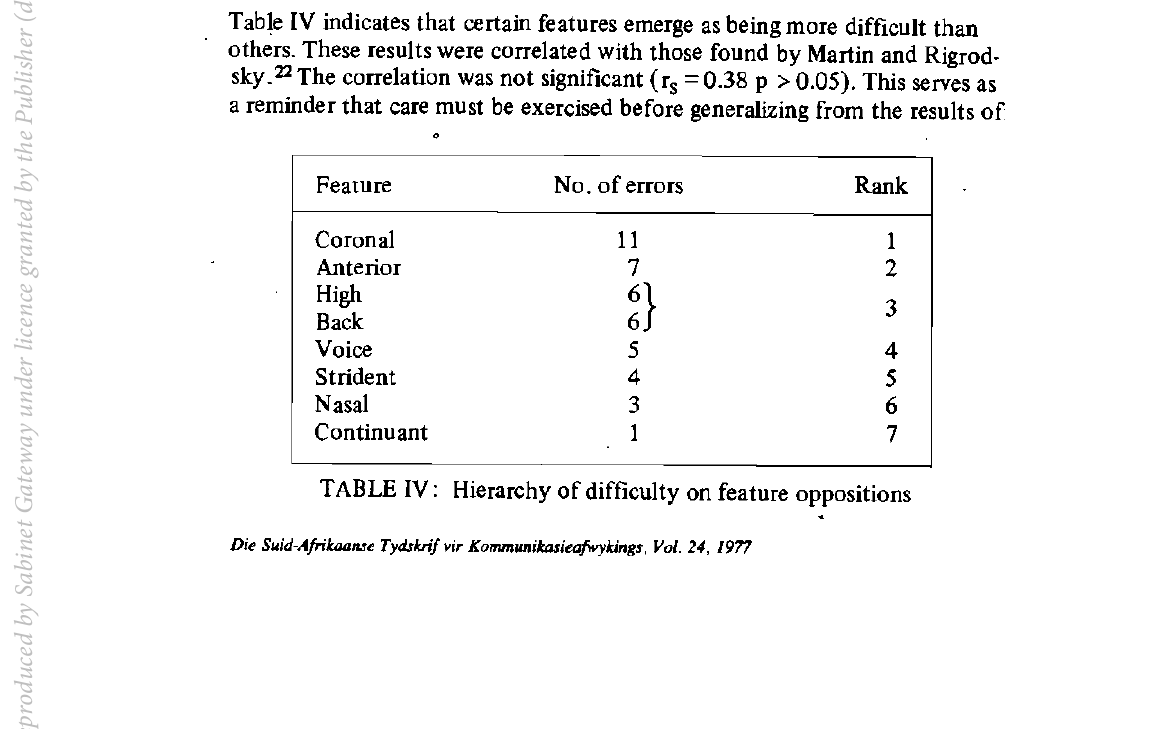
TABLE IV: Hierarchy of difficulty on feature